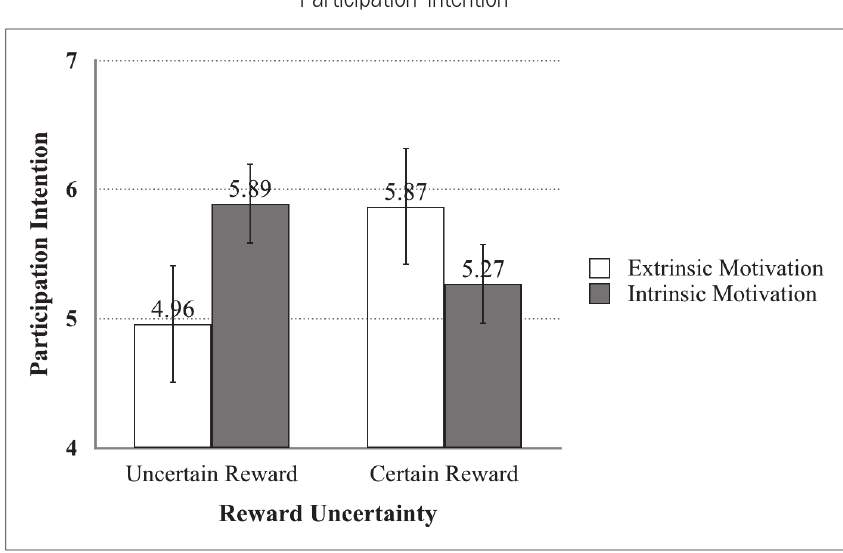
<Table 1> Two-way Interaction Effect between Reward Uncertainty and Motivation Type